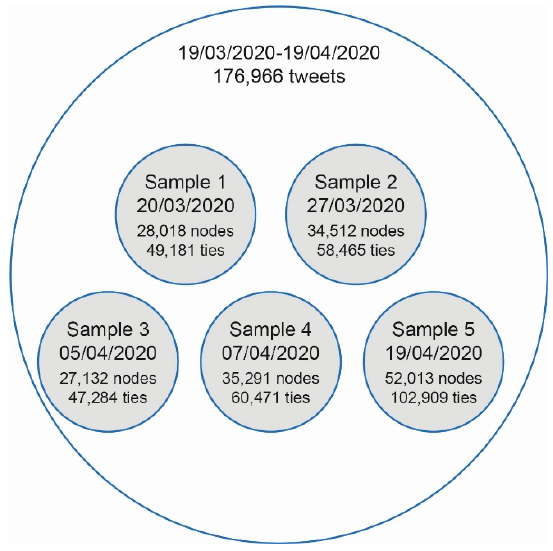
Figure 1. Samples. Figure 1.